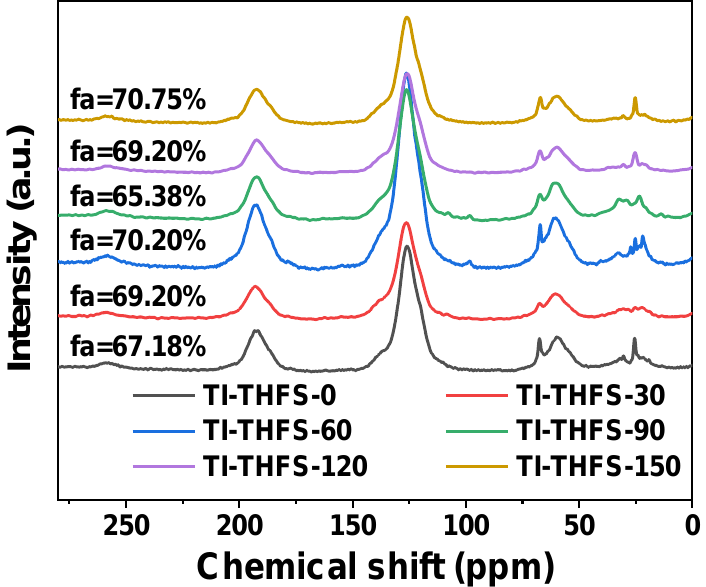
Figure 9. 13 C − NMR spectra of the TI − THFS fraction in spinnable pitch at different incubation days.